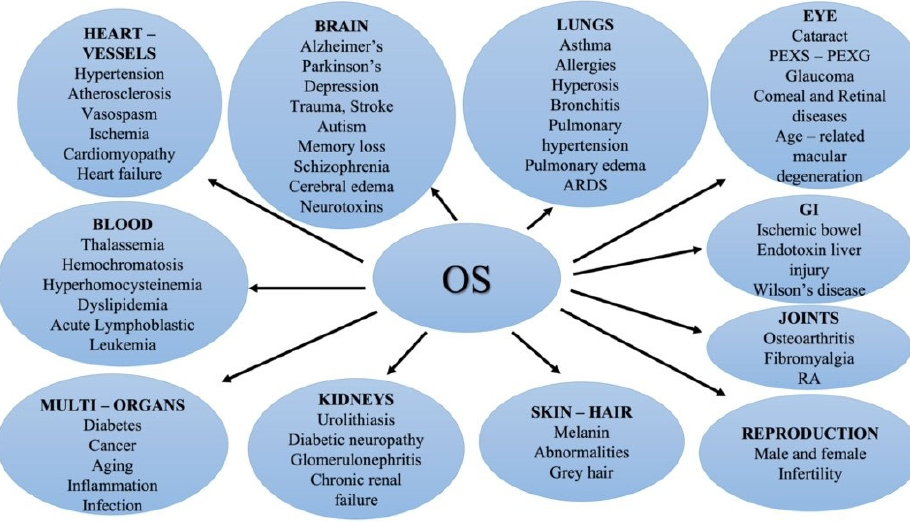
Figure 3. Organic systems and human diseases associated with OS.